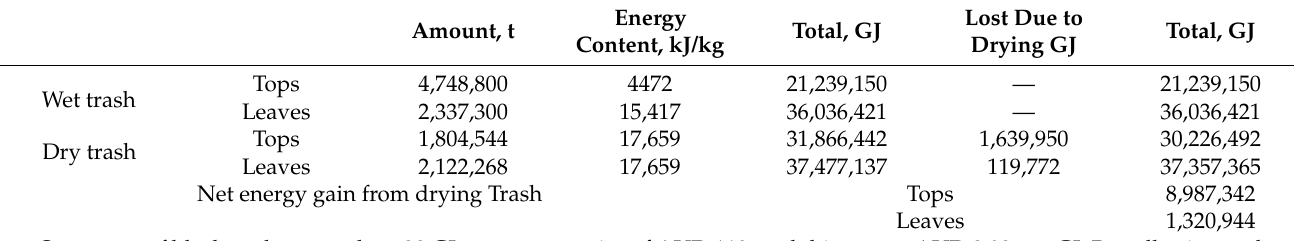
Table 25. Net energy difference between wet and dry